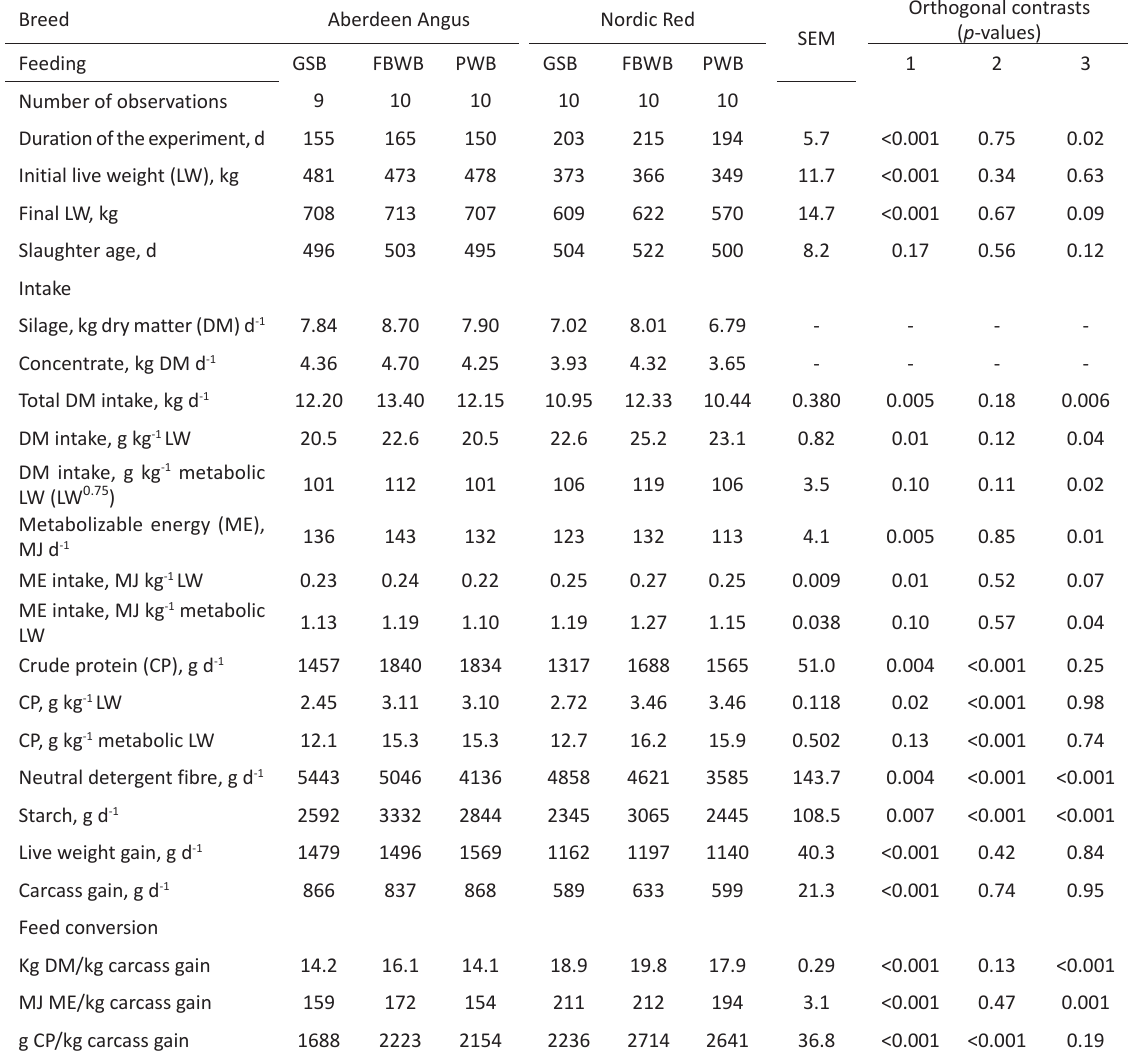
Table 2. Intake and growth performance of the bulls fed different total mixed rations Breed Aberdeen Angus Nordic Red